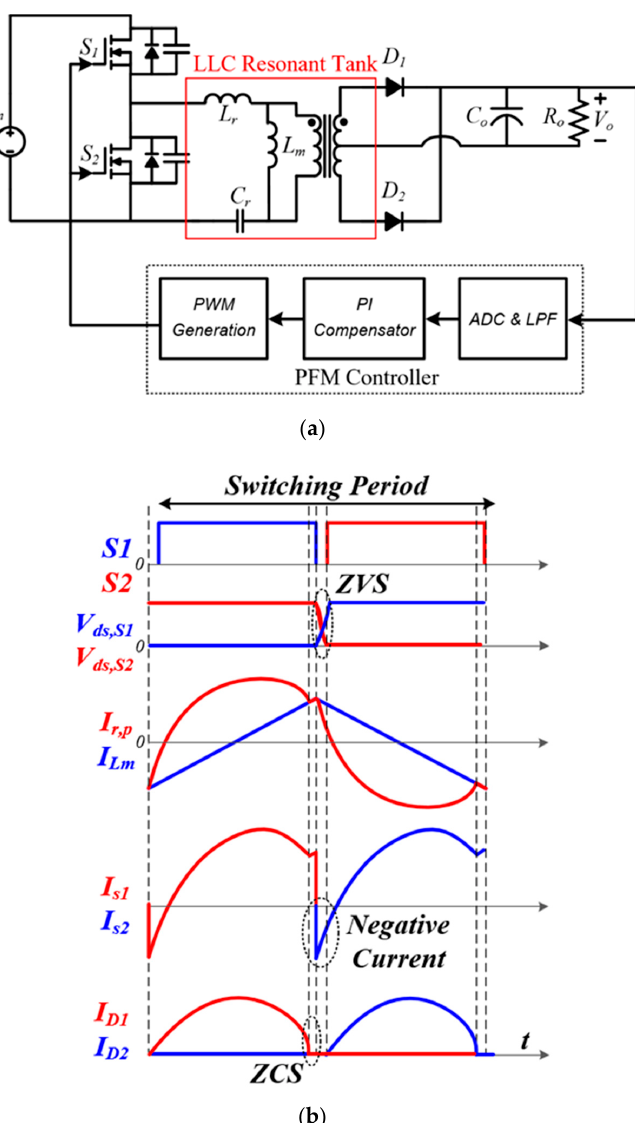
Figure 1. LLC resonant converter: ( a ) Scheme of LLC resonant tank, ( b ) Zero voltage switching (ZVS) on primary switching bridge and zero current switching (ZCS) on output